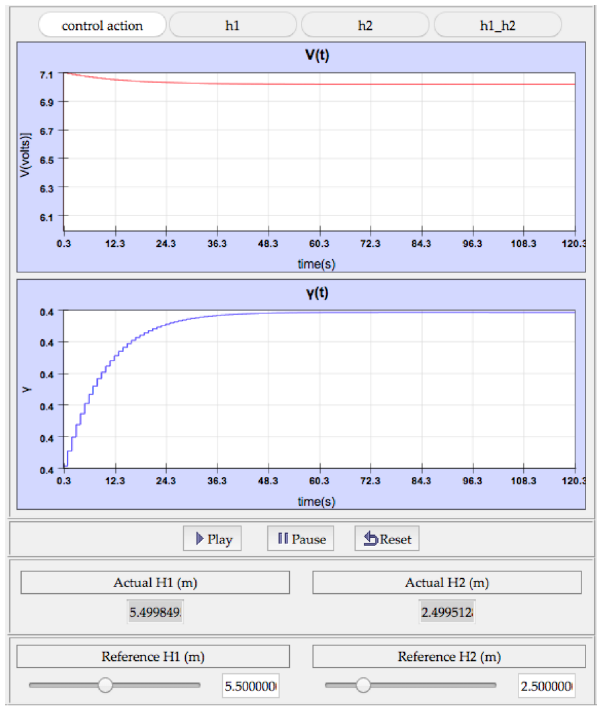
Figure 9. The evolution of the control actions considering the equations of the linearized